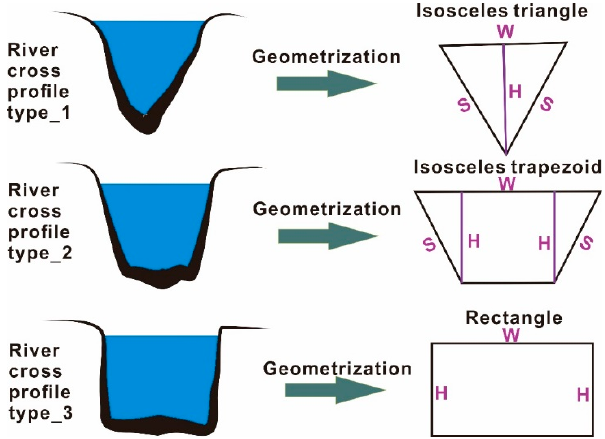
Figure 3. Schematic of the three river profiles. W is the river width, S is the length of the cross-section of the river channel, and H is the water depth.